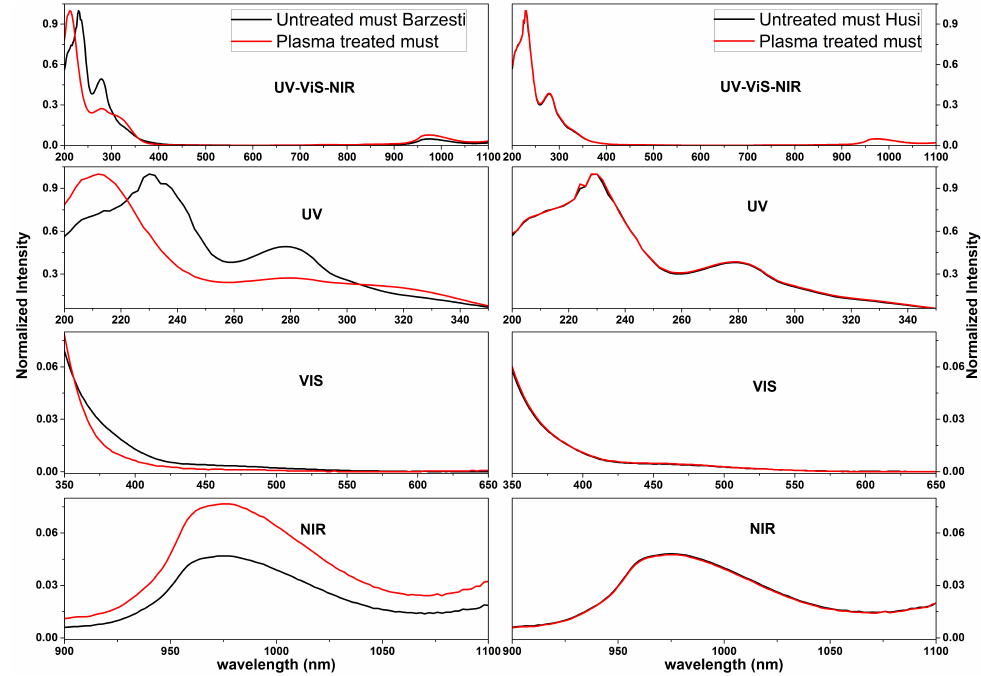
Figure 4. The absorbance spectra of untreated and treated must in the 200–1100 nm